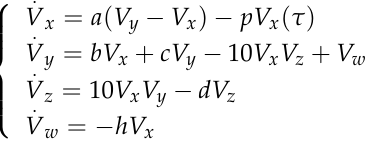
Figure 8. Time-delay module circuit.